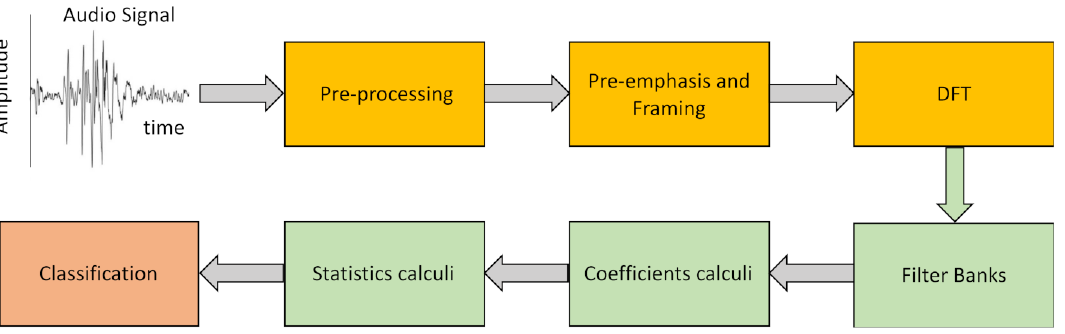
Figure 2. Temporal representation of one of the signals used in the study, followed by the steps of the analysis pipeline. DFT, digital Fourier transform. “Filter Banks” include Mel, Human Factor, and Bark